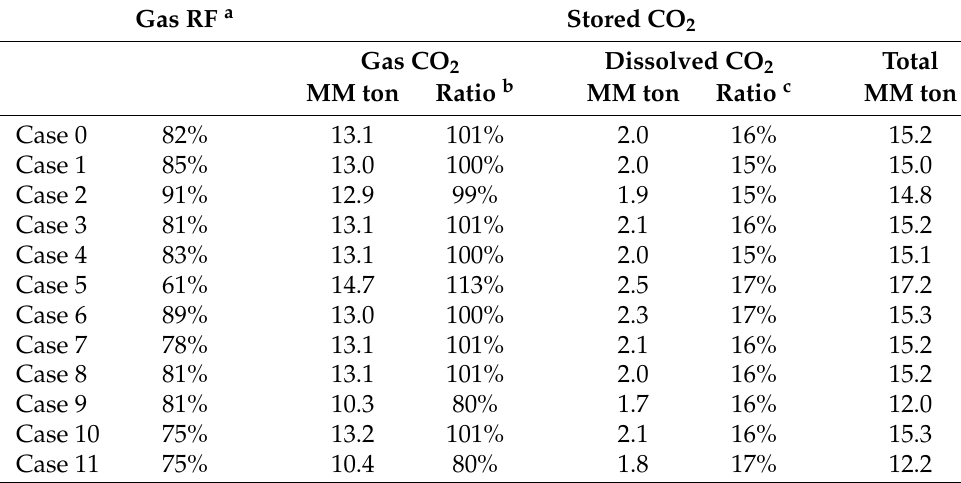
Table 4. Summary of the amount of stored obtained CO 2 from 12 simulation cases from cases 0 to 11 used in the study on the CO 2 storage capacity described in Section